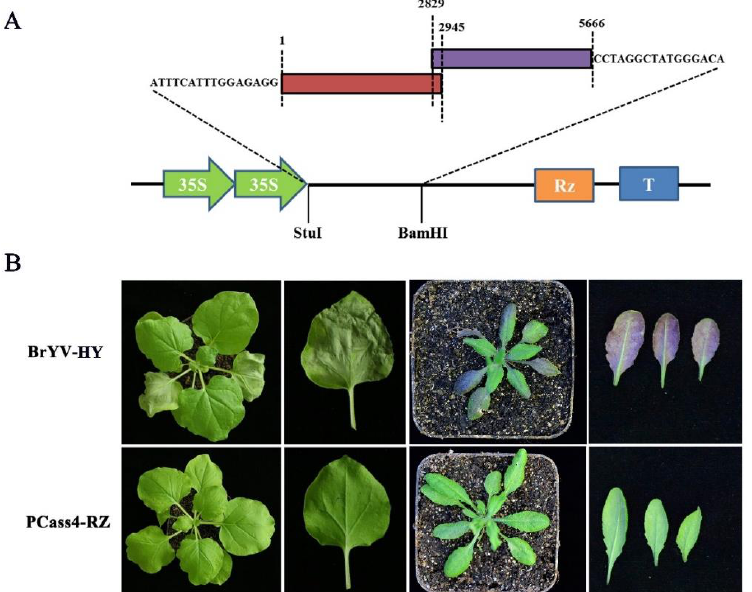
Figure 3. Pathogenicity analysis of BrYV-HY in N. benthamiana and A. thaliana plants . ( A ) Schematic representation of the construction of the full-length cDNA clone of BrYV-HY. Two overlapping segments corresponding to the complete genome of BrYV-HY were cloned into the binary expression vector pCass4-Rz between the StuI/BamHI sites by homologous recombination. ( B ) Symptoms of N. benthamiana and A. thaliana plants inoculated with BrYV-HY. Symptoms were photographed at 4 and 14 days post-inoculation (dpi). Experiments were repeated three times, and 10 − 15 plants were used for each inoculation.